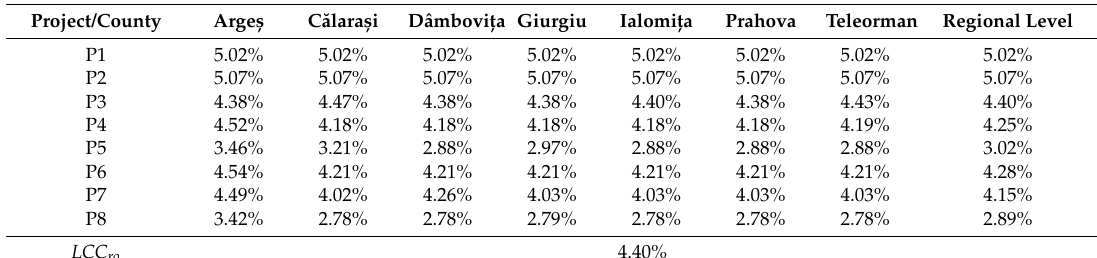
Table 7. LCC variation at the regional level for the maximum scenario (%) in the case of the increase of the energy cost by 10%.